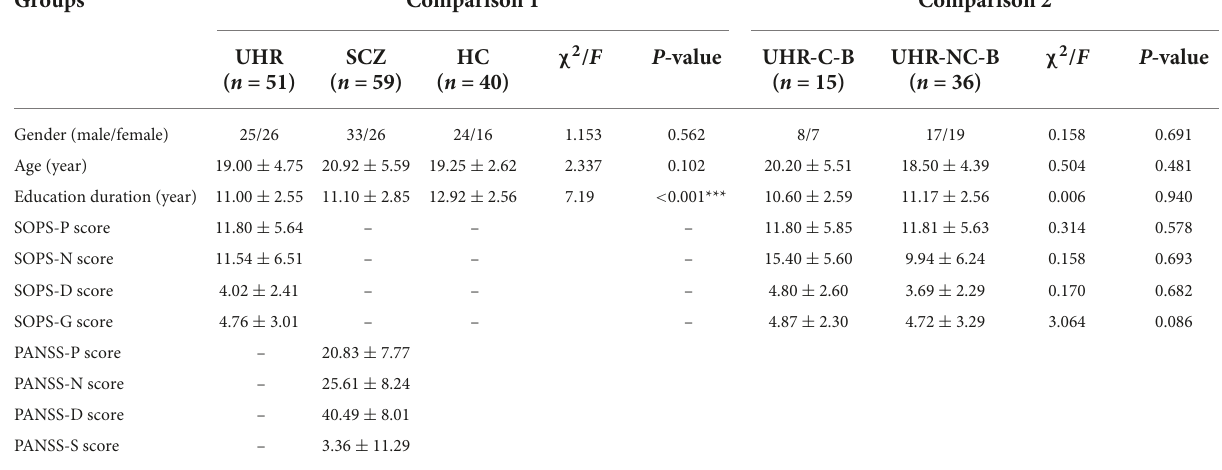
TABLE 2 Comparison of demographic and clinical